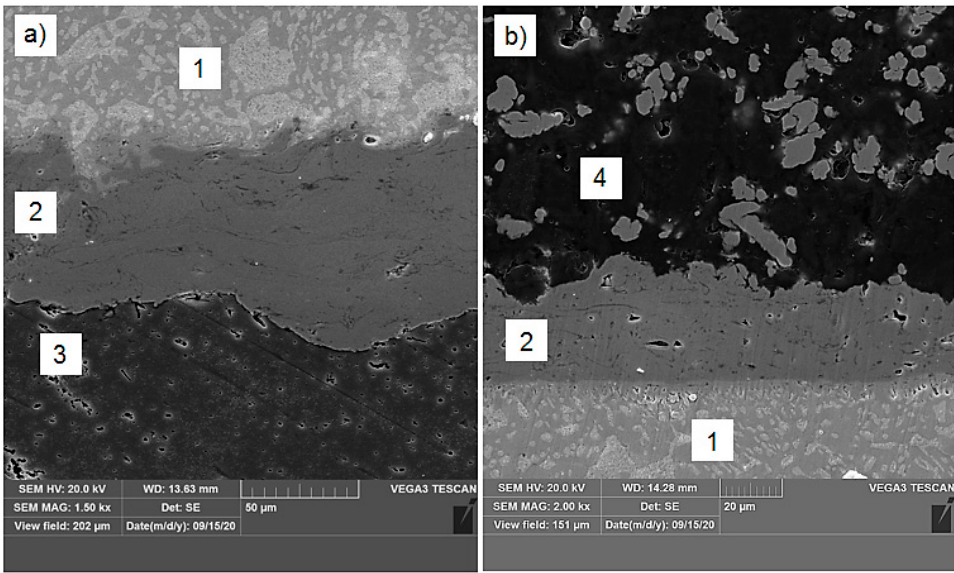
Figure 8. Interface between solder and Cu intermediate layer close to 6060 aluminum alloy ( a ) and close to graphite composite ( b ); 1—solder; 2—Cu coating; 3—6060 aluminum alloy; 4—graphite composite.